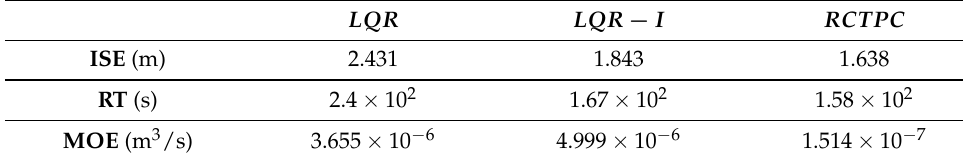
Table 1. The results of the quality criteria for the cascade multi-tank system control.